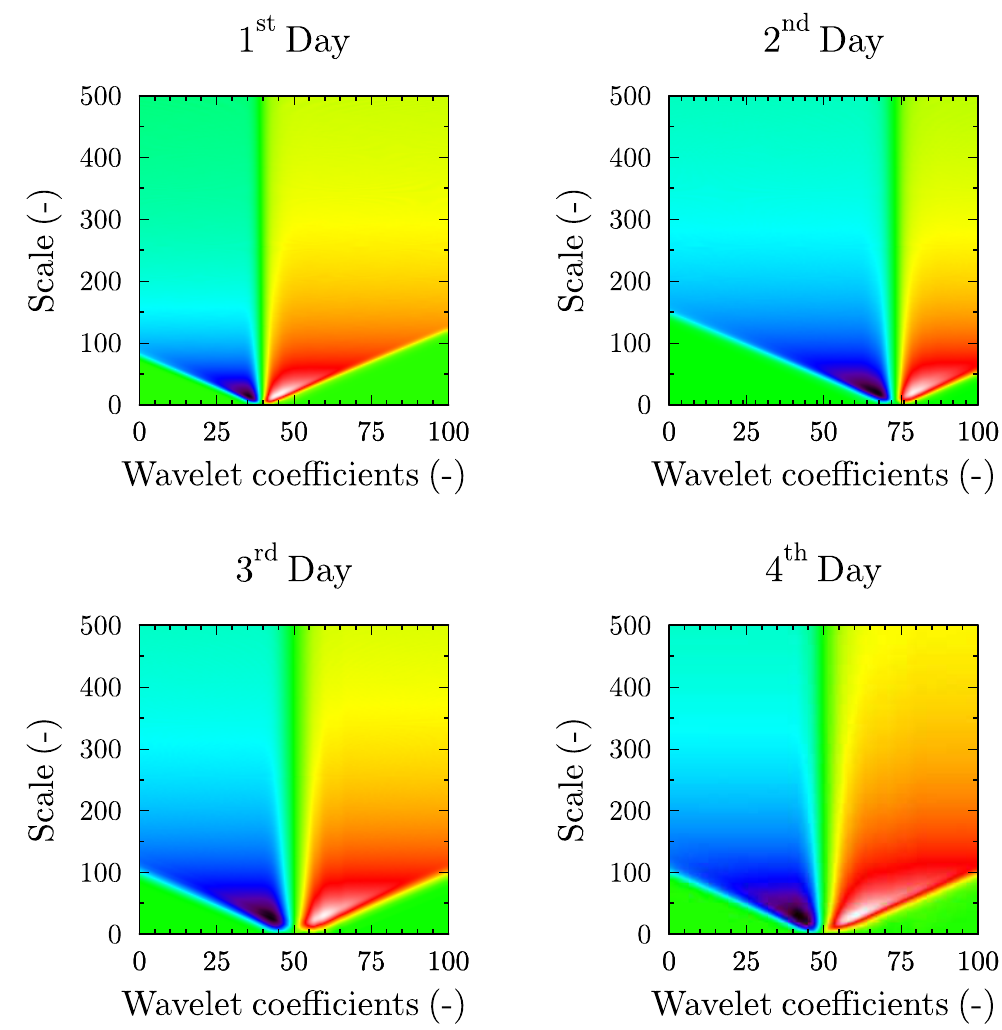
Figure 7. Scalograms of heart rate (HR) signals that were obtained for Haar wavelet related to the all days of the measurement programme. Scalograms show the result of the Continuous Wavelet Transform, based on HR signals for a selected volunteer. Each plot indicates a particular measurement day: 1st day, one day preceding the extreme physical effort; 2nd day, the day of the effort; 3rd day, one day following the effort, 4th day, two days following the